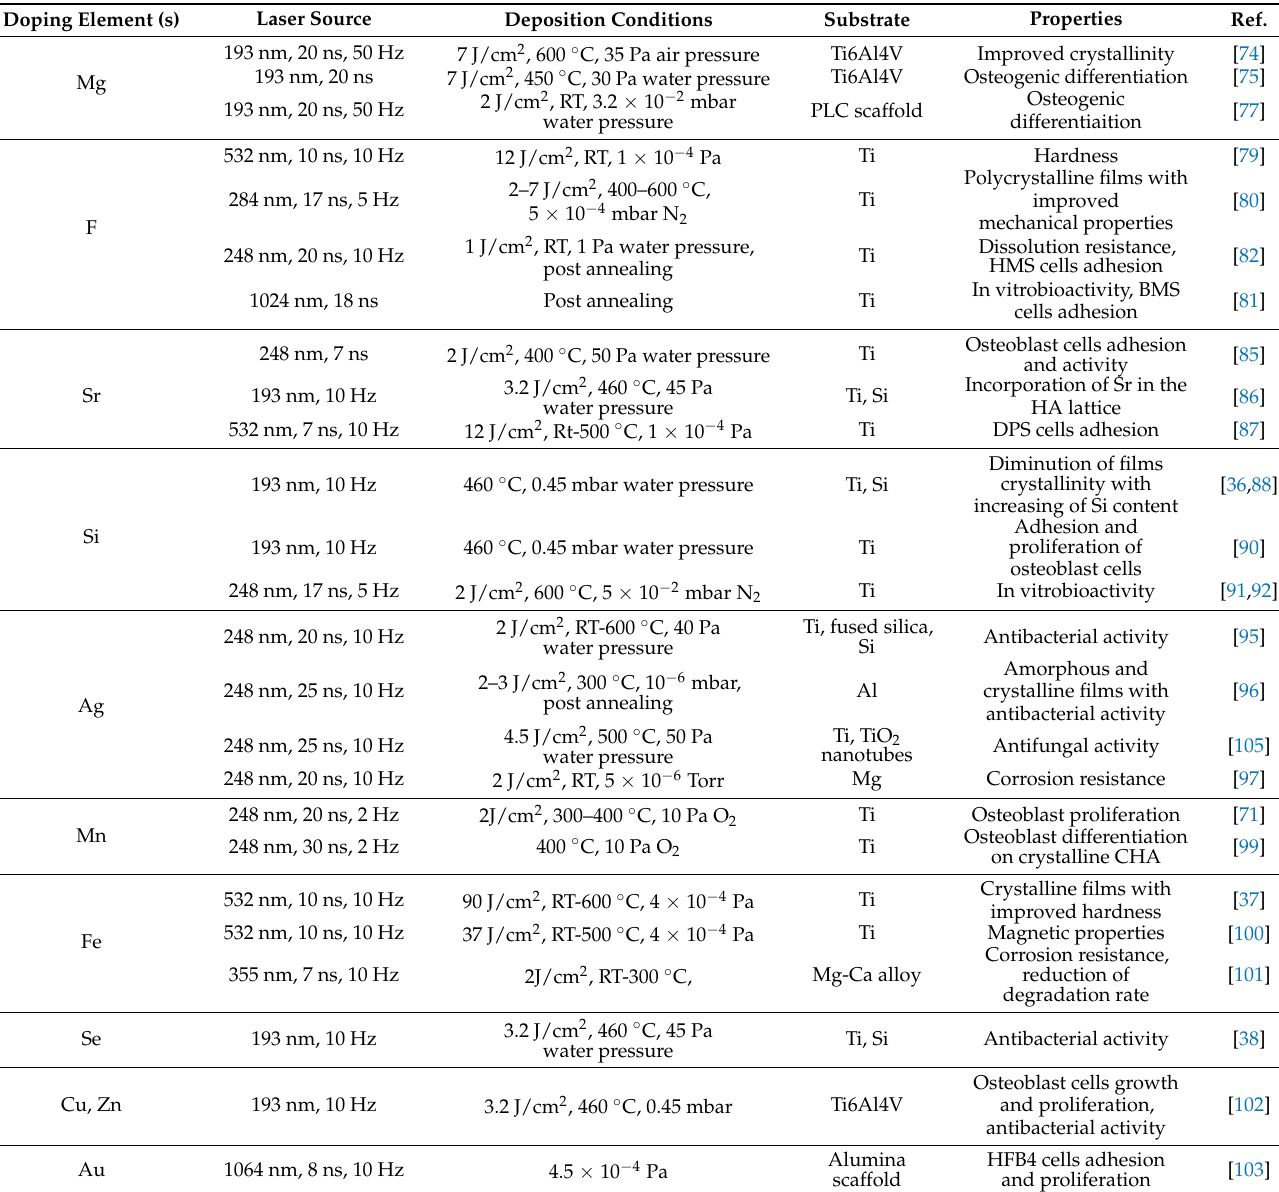
Table 2. Pulsed laser deposition (PLD) experimental details and properties of films of substituted HA. Doping Element